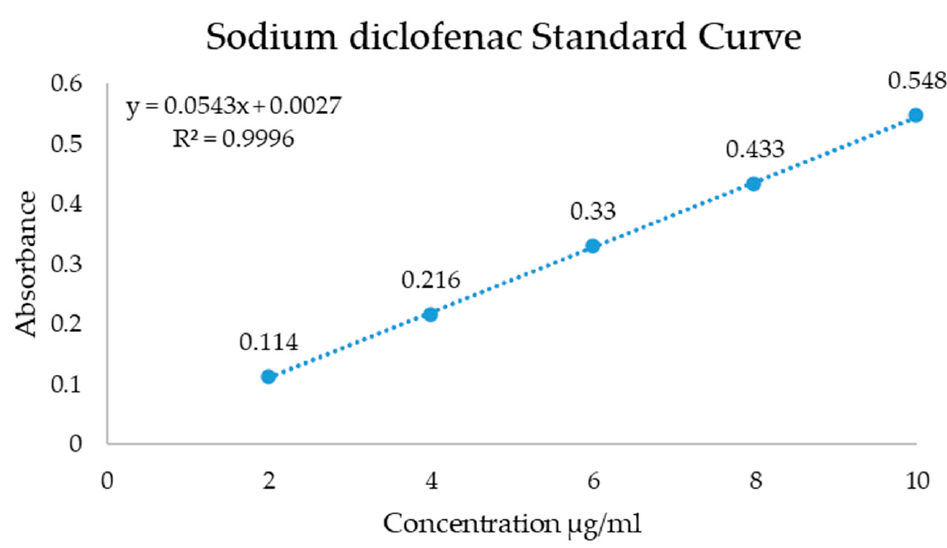
Figure 1. Standard curve for determination of diclofenac release from membranes.